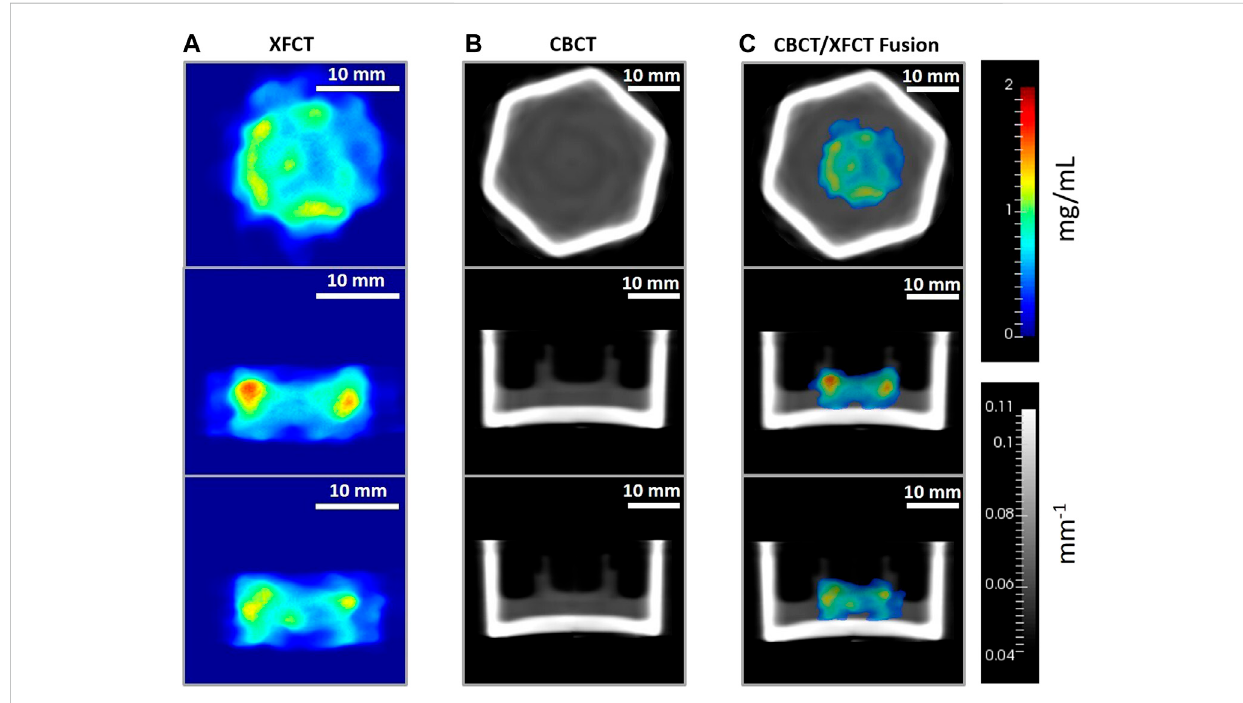
FIGURE 12 Axial (toprow), sagittal (middlerow), and coronal (bottom row)imageplanes from thetomographic reconstruction (TV-EM) ofthe 3Dbreastcancer tissue model administered with 3.15 mg/mL Gd and incubated over 48 h period. Gd concentration (mg/mL) maps from (A) XFCT reconstruction (magni fi cation factor approx. ×1.5), (B) linear attenuation coef fi cient (mm − 1 ) maps of the cell crown/holder held inside borosilicate glass container with cell-culturegrowthmedium,obtainedfromtheCBCTscans,and (C) XFCTimagedatafusedwithCBCTimages.For (C) ,thresholding < 0.31 mg/mL is applied to the voxels, i.e., cut off below the detection limit. While CBCT remains invariant, the low contrast detectability of the XFCT technique with small added Gd concentrations can be clearly seen. The rainbow color bar shows the Gd concentration (mg/mL). The grayscale color bar shows the attenuation coef fi cients (mm − 1 ). Scale bar: 10